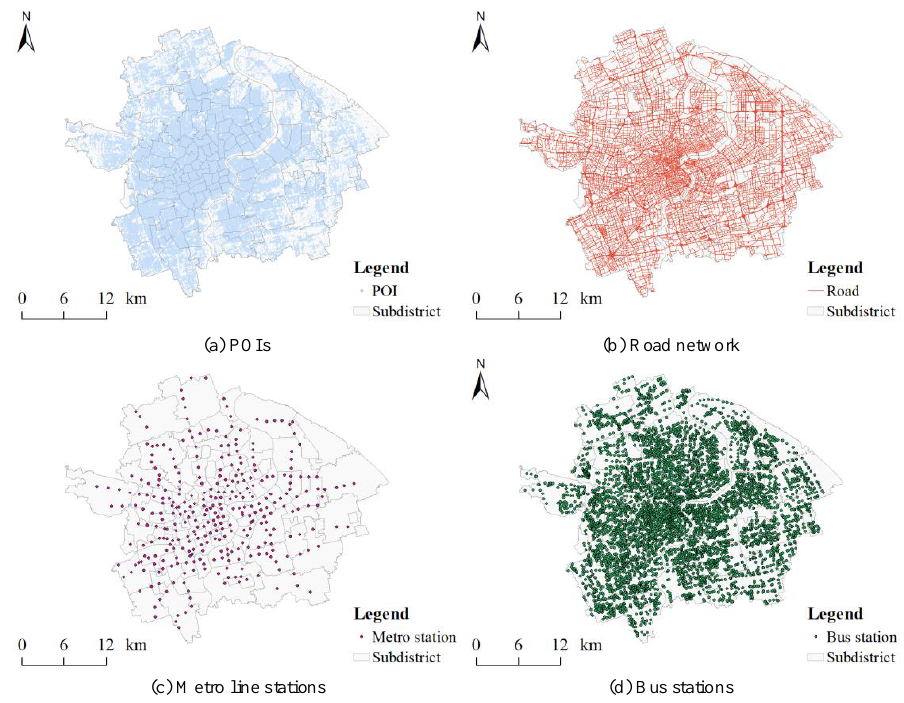
Figure 2. Overall distribution of ( a ) POIs, ( b ) Road network, ( c ) Metro line stations, and ( d ) Bus stations.